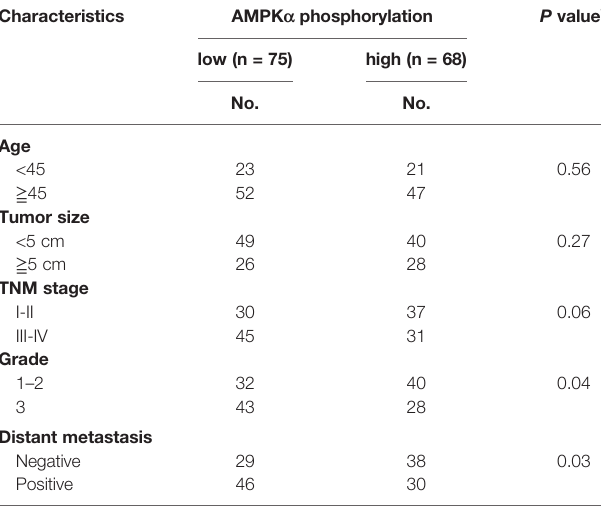
TABLE 2 | Characteristics of AMPK a phosphorylation in BC